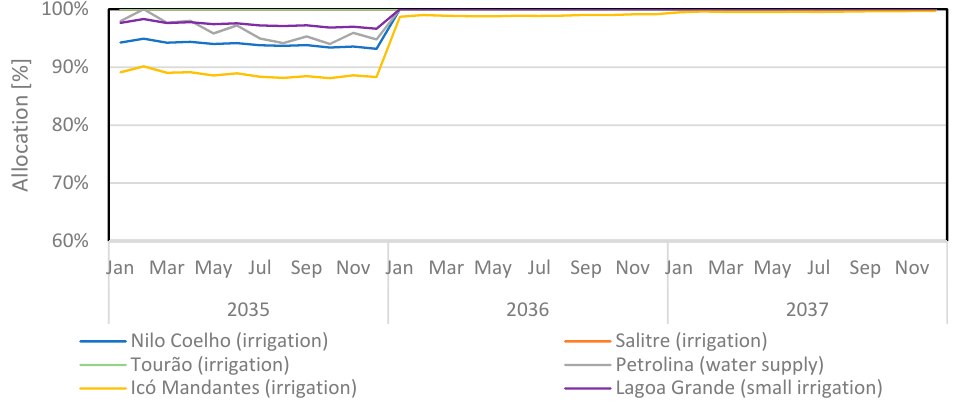
Figure 8. Allocation of water to the PISF (water transfer project) in scenario Fragmentation (A2).